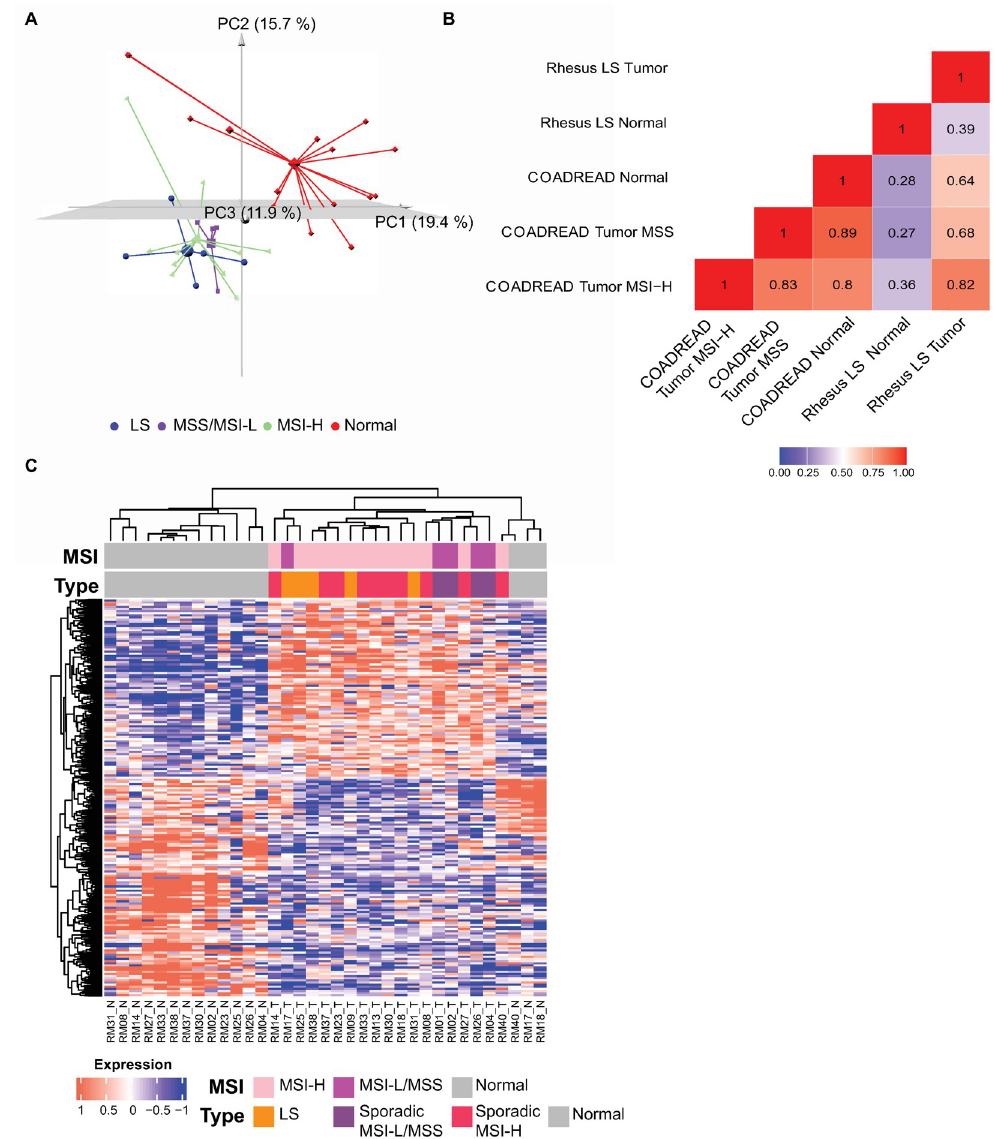
Fig 4. Transcriptomic analysis of rhesus CRC. ( A ) 3D principal component analysis (PCA) of rhesus CRC gene expression profiles show clear separation among sporadic MSI-H samples (green pyramids), sporadic MSS and MSI-L (purple spheres), Lynch syndrome (blue cubes), and normal tissue (red diamonds). Normal tissue samples clustered separately from tumor tissue samples; (B) Pearson’s correlation coefficient of mean expression levels across 101 significant genes from COAD-READ MSI-H tumor samples, COADREAD MSS tumor samples, COADREAD normal tissue samples, rhesus LS tumor samples, and rhesus normal tissue samples; (C) Significant differentially expressed genes (DEGs) between tumor and normal tissue samples. DEGs were found based on BH-adjusted P -value � 0.05 between rhesus colorectal normal and tumor. Pearson’s correlation was used to perform hierarchical clustering between rhesus tumor and normal tissue samples. Columns represent samples, and rows represent statistically significant differentially expressed genes. MSI bar displays MSI status of samples based on PCR-based MSI testing. Gray color represents normal, pink MSI-H, and magenta MSS and MSI-L tissue samples. MSI type bar displays MLH1 genotyping data with gray color representing normal, orange LS, purple sporadic MSI-L and MSS and red sporadic MSI-H tissue samples.